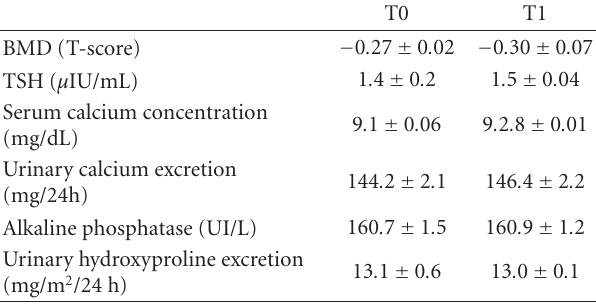
Table 2: Bone mineral density (BMD), TSH and markers of osteoblastic and osteoclastic activities before (T0) and two years (T2) after followup in 50 postmenopausal patients did not receive any therapy (control